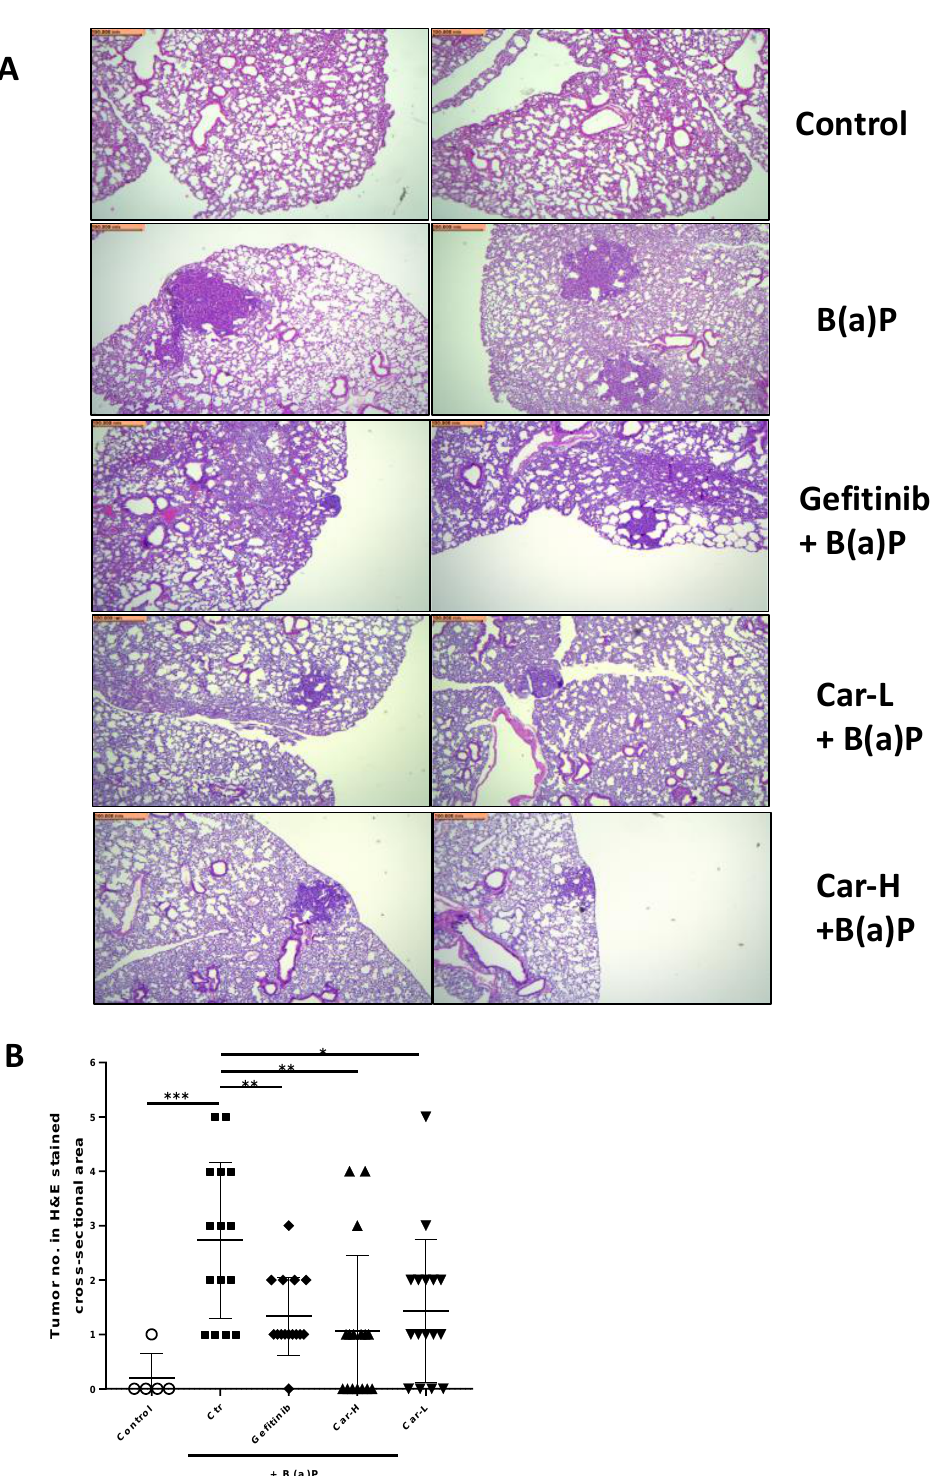
Figure 5. Effects of carvedilol on B(a)P-induced lung carcinogenesis. ( A ) Representative H&E-stained cross-sections of lungs from each treatment group ( × 4). Scale bars: 500 µ m. ( B ) Number of tumors in H&E-stained cross-sectional areas of each block. Data are expressed as mean ± SD. An ordinary one-way ANOVA followed by Dunnett’s multiple comparison test was used to assess statistical differences. *: p < 0.05, **: p < 0.01, ***: p < 0.001.